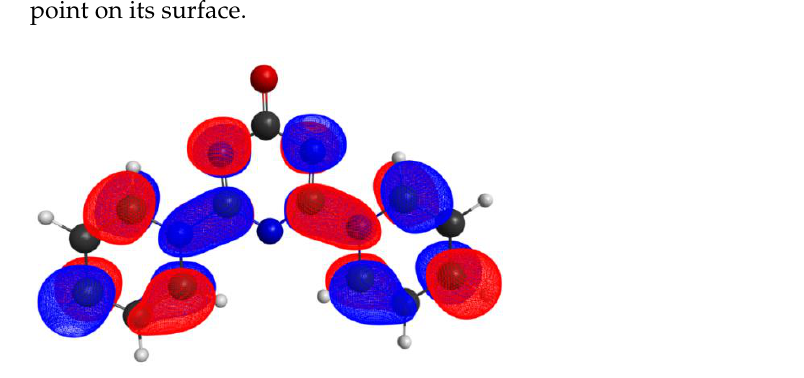
Figure 10. 4,6-Dipyridinio-2-oxido-1,3,5-triazine perrhenate: its LUMO is a π -type orbital delocalized over almost the entire cation.